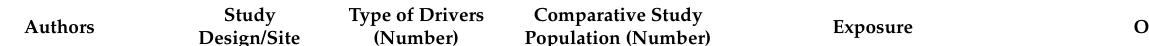
Table 4. Studies on car taxi drivers included in the